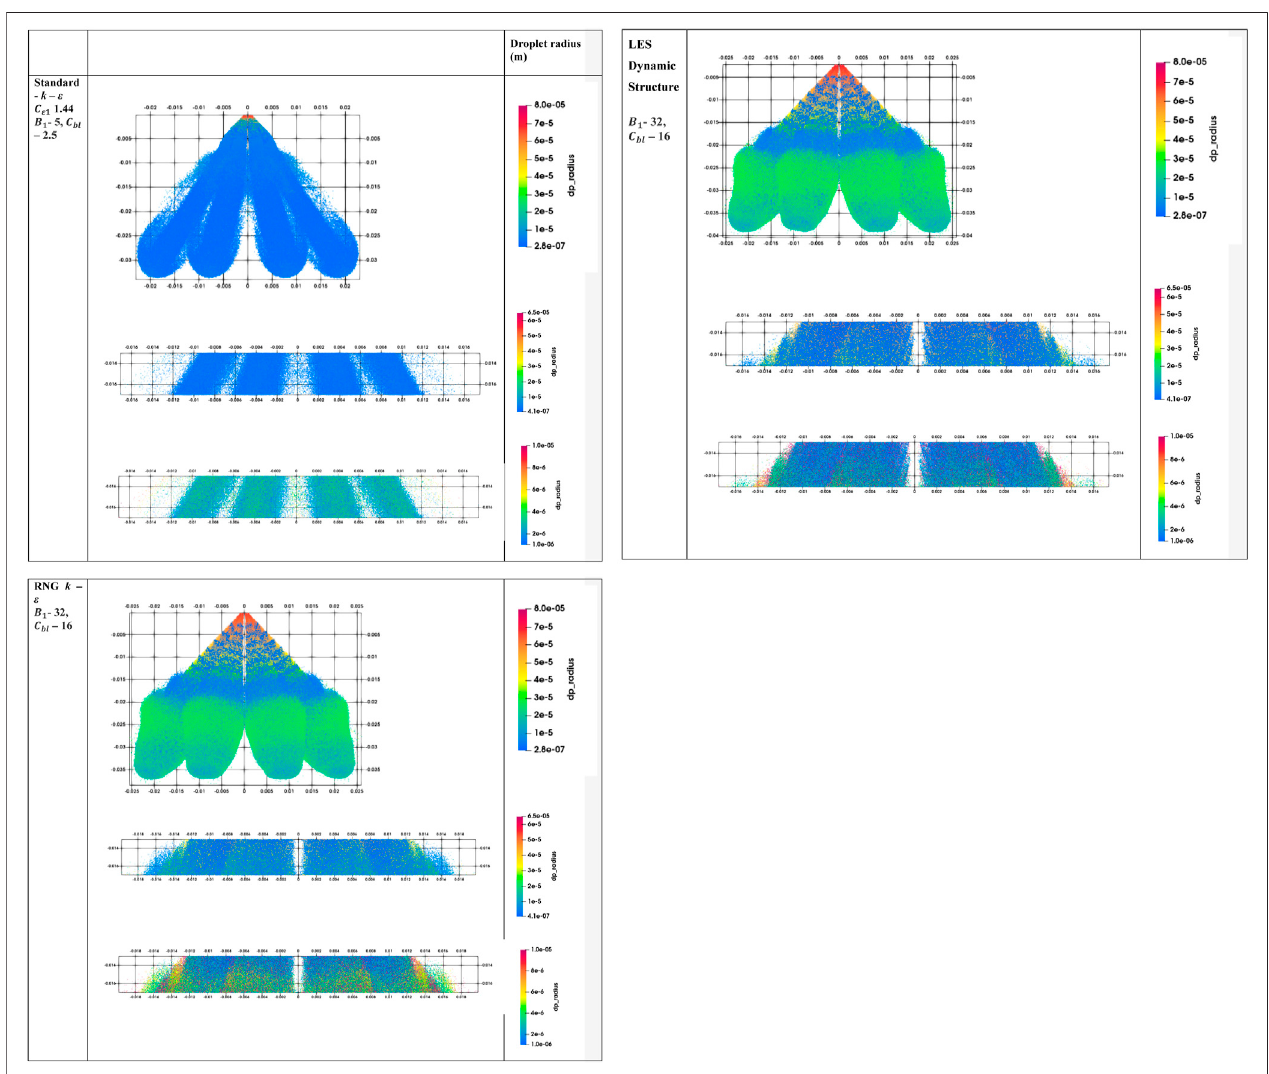
FIGURE 10 | Comparison of the predictions of parcel radii at 0.8 ms using three different modeling approaches [Standard k – ε turbulence model used with C ε 1 = 1.35,1.40,and1.44; B 1 =5, C bl =2.5,cone-angle25 ° ,plumetargetingangle35 ° andallothercaseswith B 1 =32, C bl =16,cone-angle25 ° ,plumetargetingangle35 °